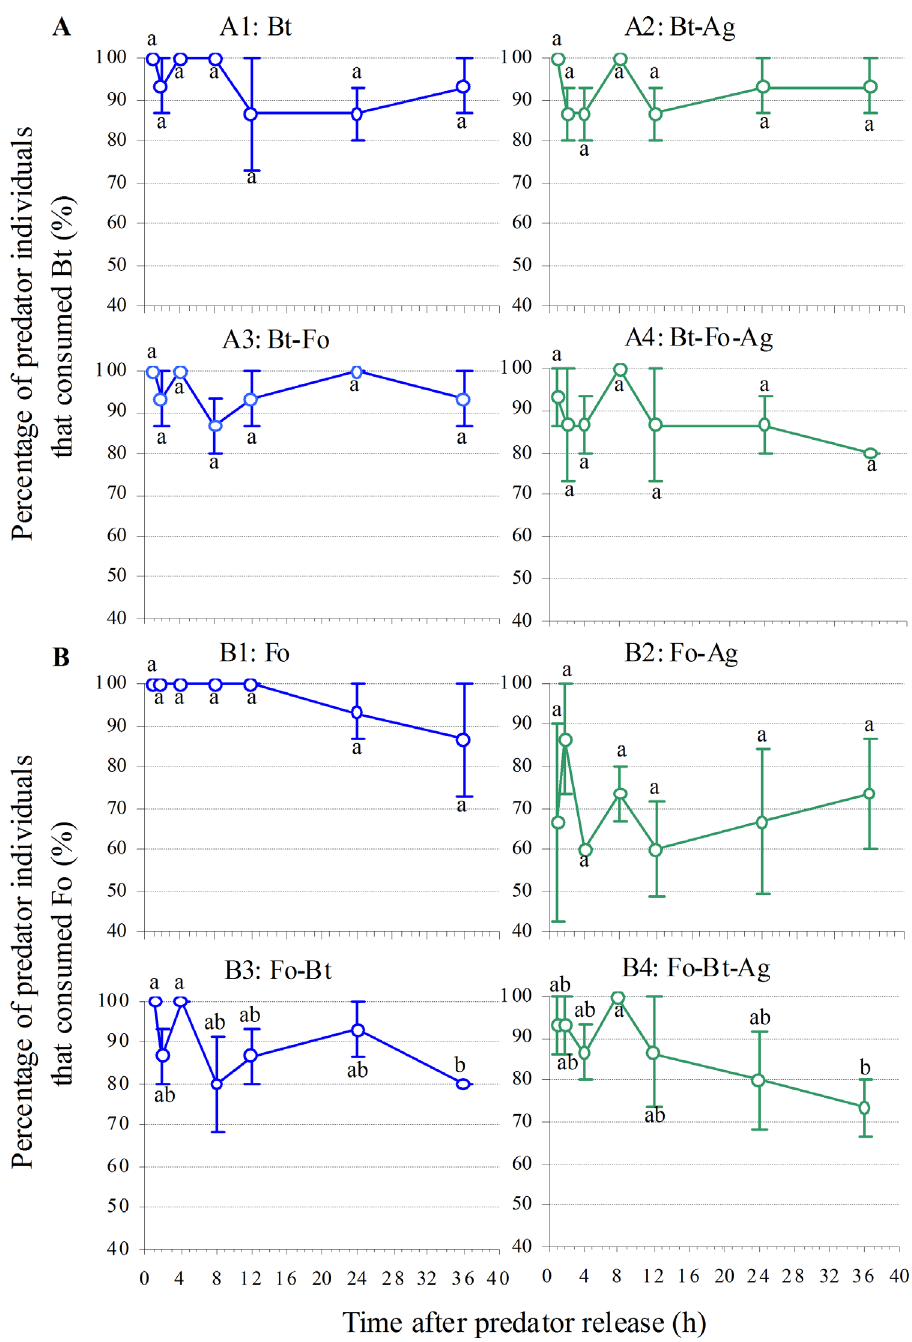
Fig 1. Mean percentage of predator individuals (n = 3 cages; ± 1 SE) that consumed (A) Bemisia tabaci MEAM1 (Bt) or (B) Frankliniella occidentalis (Fo) in various prey species combinations . Means within a treatment followed by different lower case letters differ at P < 0.05 (one-way ANOVA, LSD test). Abbreviation: Ag — A . gossypii